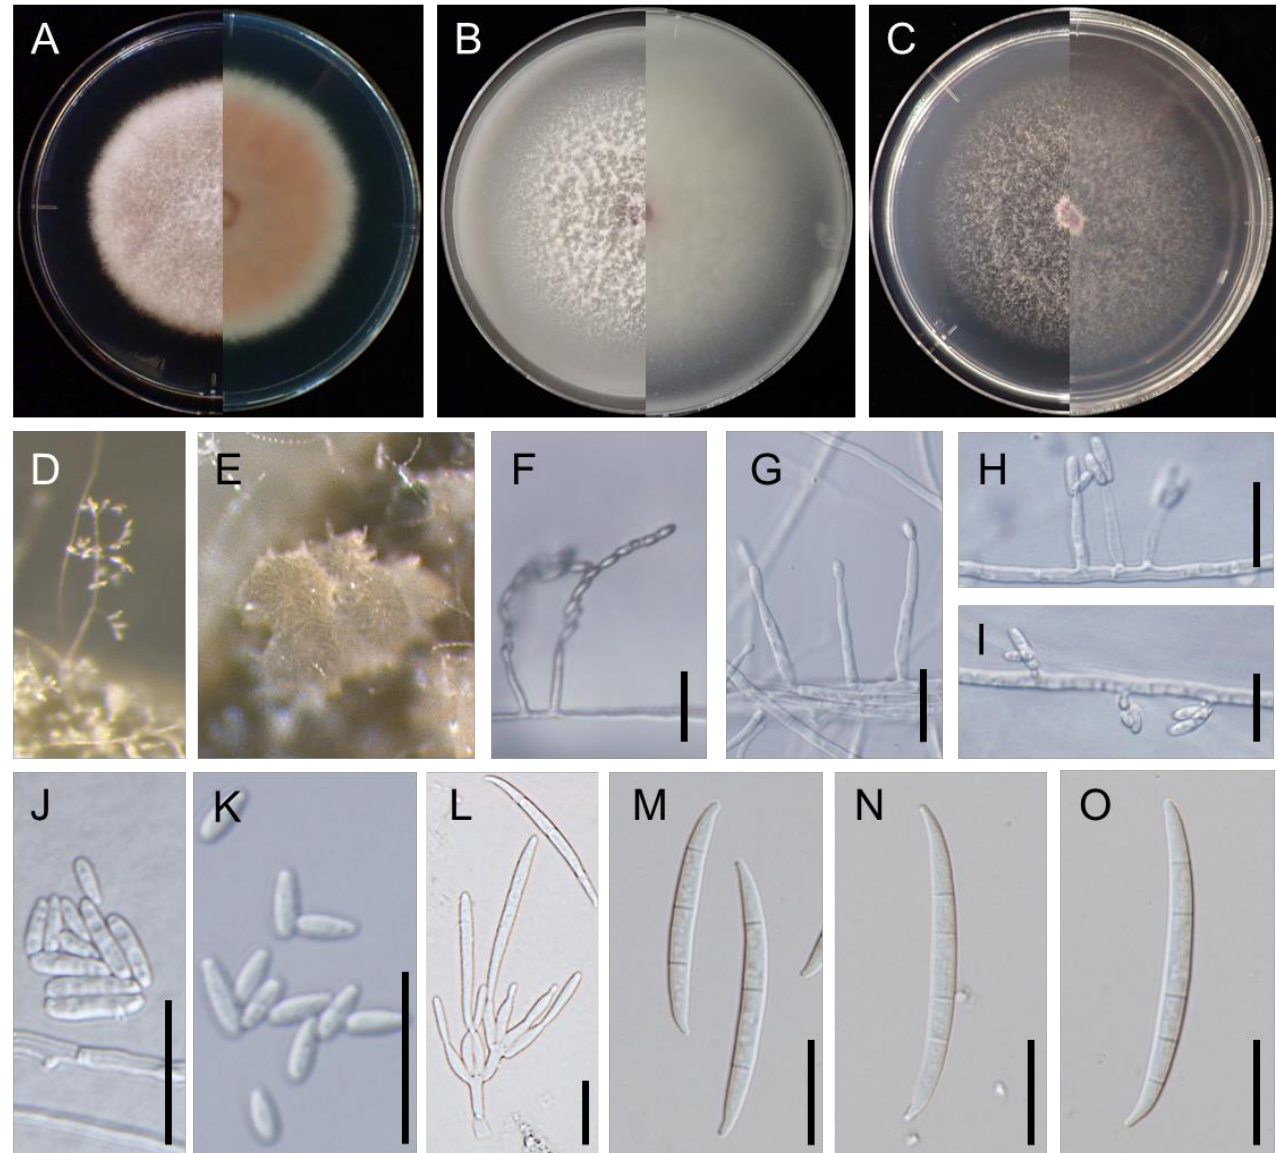
Figure 3. Colony morphology of F. mindanaoense (PD20-05T; ex-type culture PD20-05) after 6 days growth at 25 °C in the dark: ( A ). PDA; ( B ). OA; ( C ). SNA. Colony surface is shown on left half of each plate and colony undersurface on right half. ( D ). Conidiophore on carnation leaf; ( E ). sporodochia on carnation leaf; ( F , G ). microconidia on a conidiophore on aerial hyphae on SNA; ( H , I ). microconidia on a conidiophore on hyphae inside SNA; ( J ). microconidia on a carnation leaf; ( K ). microconidia on SNA; ( L ). conidiophores and phialides on sporodochia; ( M – O ). sporodochial conidia (macroconidia): ( M ). 3-septate conidia; ( N ). 4-septate conidia; ( O ). 5-septaate conidia. Scale bars: 20 µm. Sporodochia milk white formed on carnation leaves deficiently. Conidiophores in sporodochia were verticillately branched; bearing apical pairs were monophialide, while sporodochial phialides subulate to subcylindrical. Sporodochial macroconidia falcate